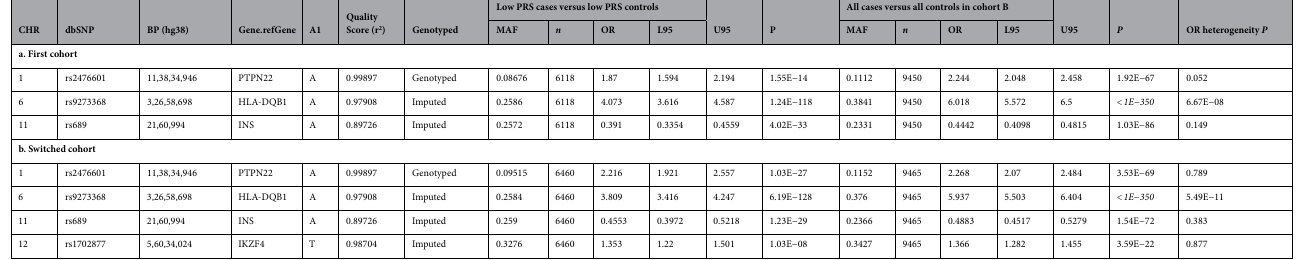
Table 2. Leading SNPs at three loci have been established of T1D association. Italic values indicate the smallest P